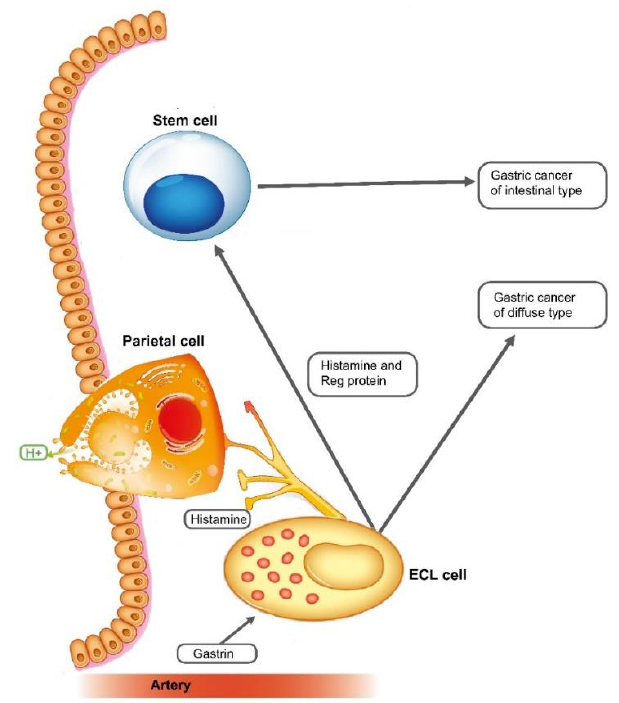
Figure 1. Gastrin and the ECL cell are central in gastric physiology and carcinogenesis.